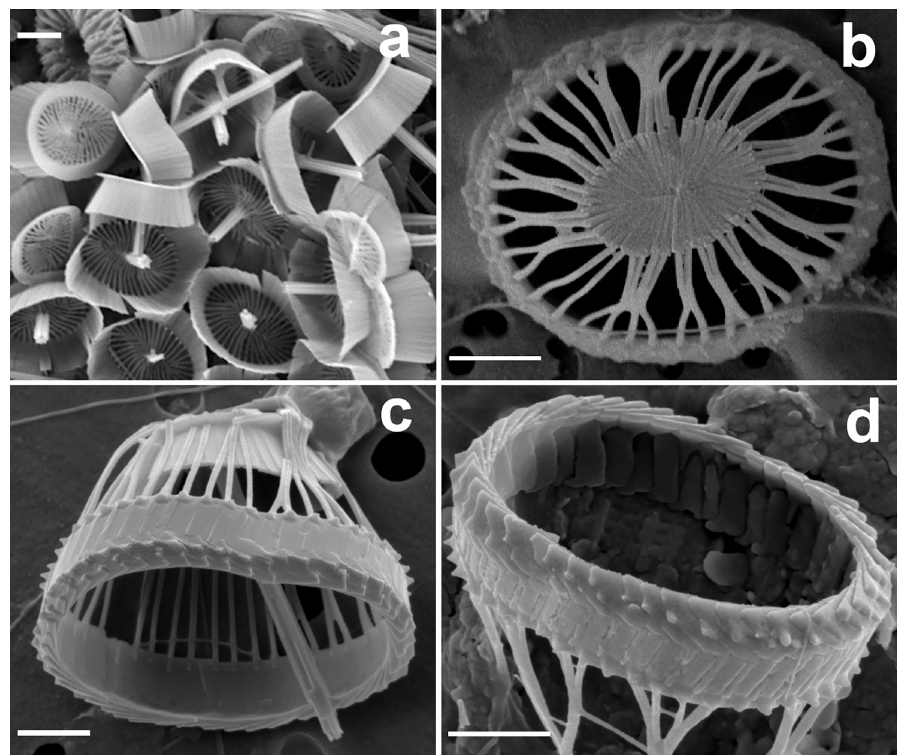
Figure 2. Details of coccoliths of Syracosphaera winteri . (a) Endothecal body coccoliths with short central processes and circum-flagellar coccoliths with longer ones extending perpendicular to the coccolith plane (GoA, 17 August 2017, 80m). (b) Distal view of exothecal coccoliths showing the central area and arrangement of laths (Mater II Stn 69/11, October 1999, 42.5m). (c) A circum-flagellar coccolith appears inside an exothecal coccolith, likely an artifact of sampling (AMT18 CTD089, 2 November 2008, 72m). (d) Slightly etched external coccolith specimen showing clockwise and anticlockwise imbrications of the rim (AMT14 CTD26, 8 May 2004, 120m). Scale bars: